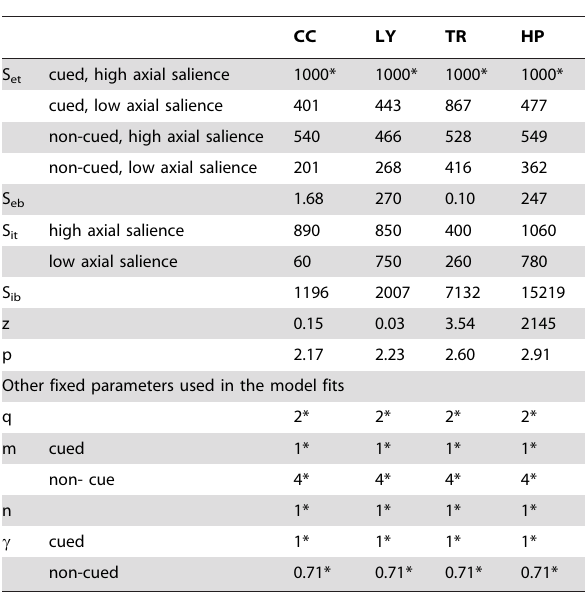
Table 1. Fitted model